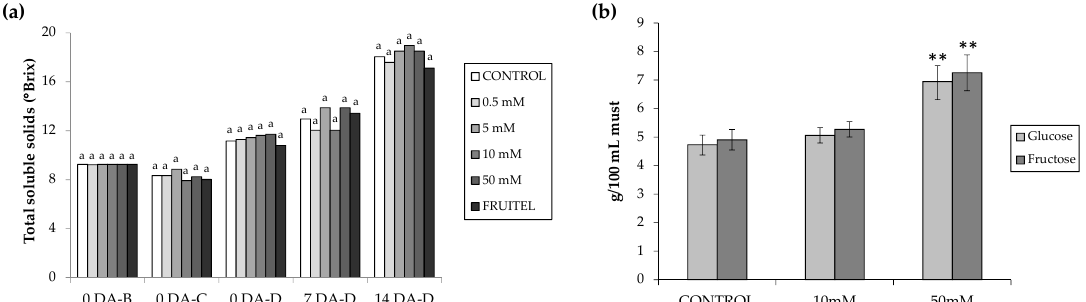
Figure 4. Effect of HB treatments on the sugar content of Vitis vinifera L. cv Alicante Bouschet berries. ( a ) Total soluble solids (° Brix) of non-treated (CONTROL) plants, HB weekly-treated plants at different concentrations (0.5, 5, 10, 50 mM) and plants treated with the ripening inducer FRUITEL. ( b ) Glucose and fructose content in must of berries from CONTROL and HB-treated plants at 7 DA-D. An ANOVA test was performed, and same letter indicates no statistical significances with a p -value < 0.05. Asterisks (**) indicate statistically significant differences between control and treated plants at each concentration with p < 0.01.